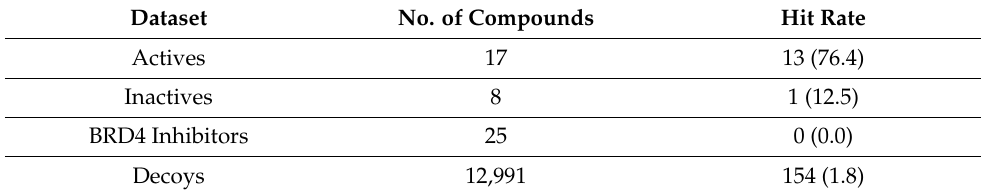
Table 1. Pharmacophore hit-rates of different data